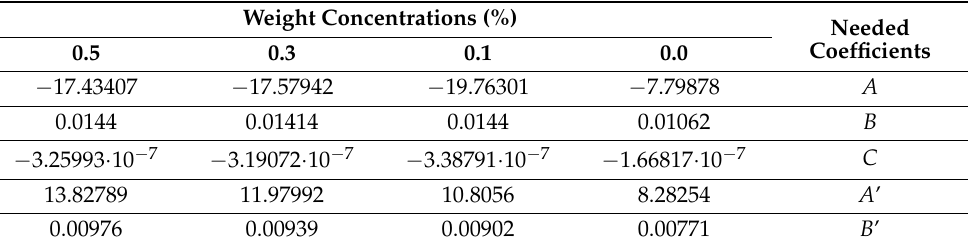
Table 3. Coefficients required to solve equations of Table 2 in terms of Nusselt number at different weight concentrations [54,55].